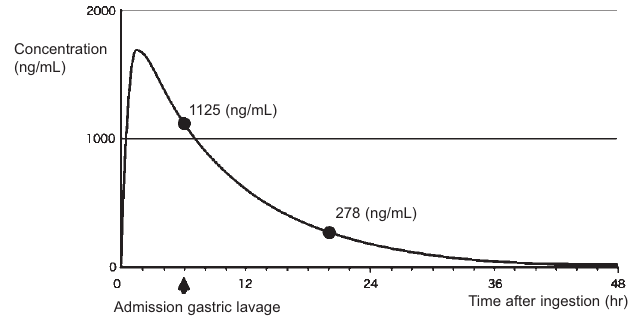
Figure 1. Pharmaco- kinetic analysis of thioridazine con- centration. Closed circles indicate the observed values in the